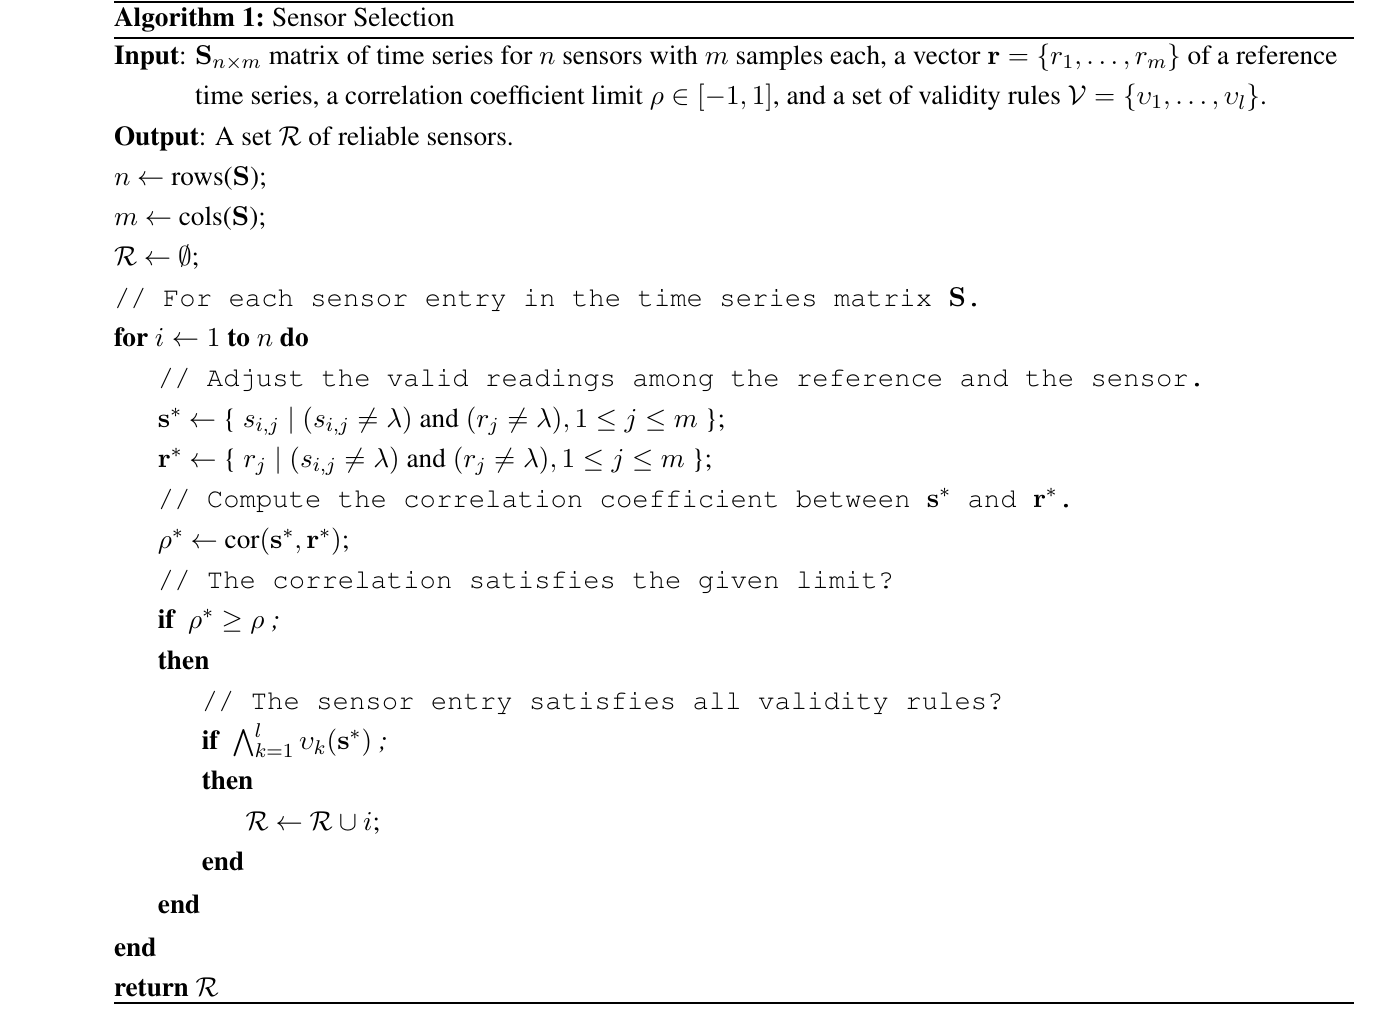
Figure 5. ( a ) Scatter plot between a temperature and a carbon monoxide sensor; and ( b ) the analysis of its correlation coefficient when the number of samples increases (Dataset 2). Algorithm 1: Sensor